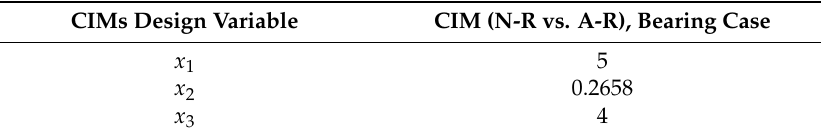
Table 3. Optimum design variables-bearing case.